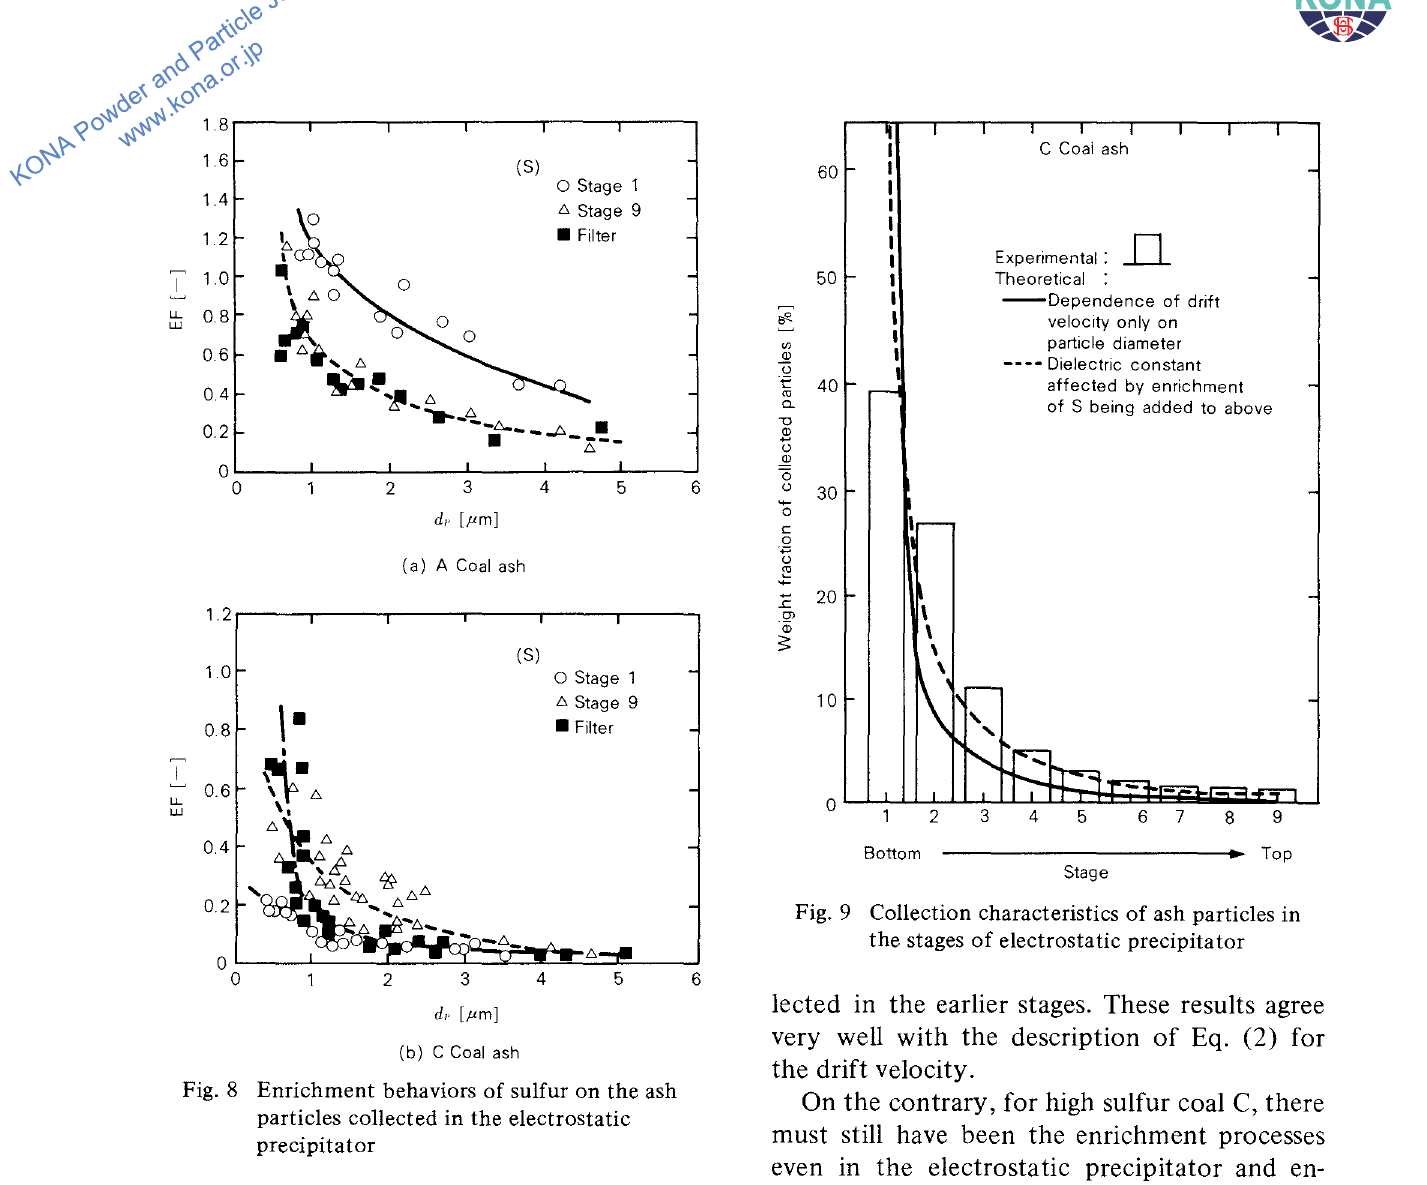
Fig. 8 Enrichment behaviors of sulfur on the ash particles collected in the electrostatic precipitator